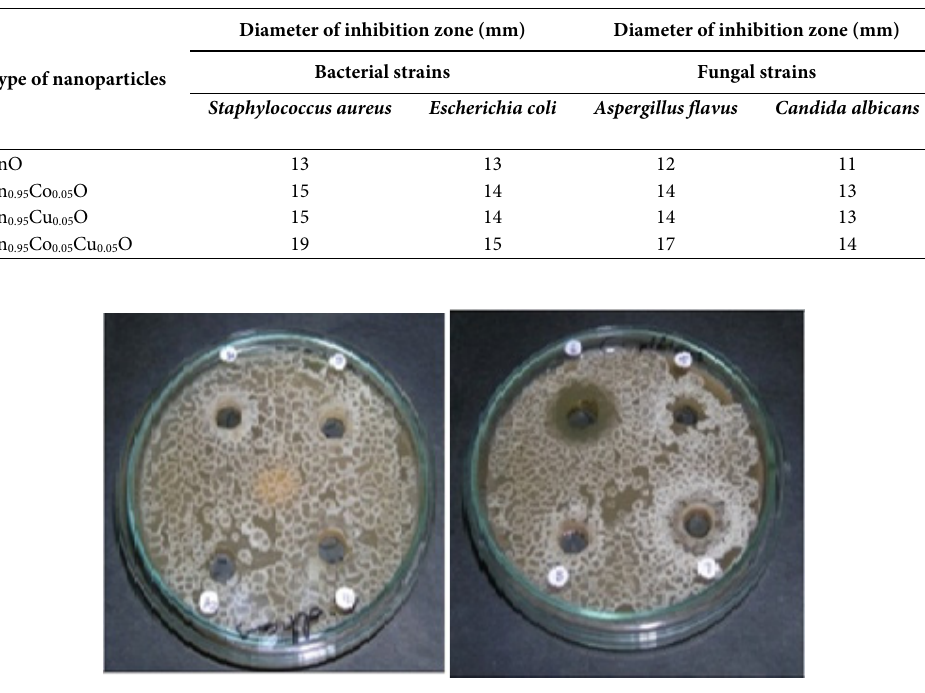
Fig. 11 Antifungal activity of ZnO, Co-ZnO, Cu-ZnO and (Co, Cu)/ ZnO Nps against Aspergillus flavus and Candida